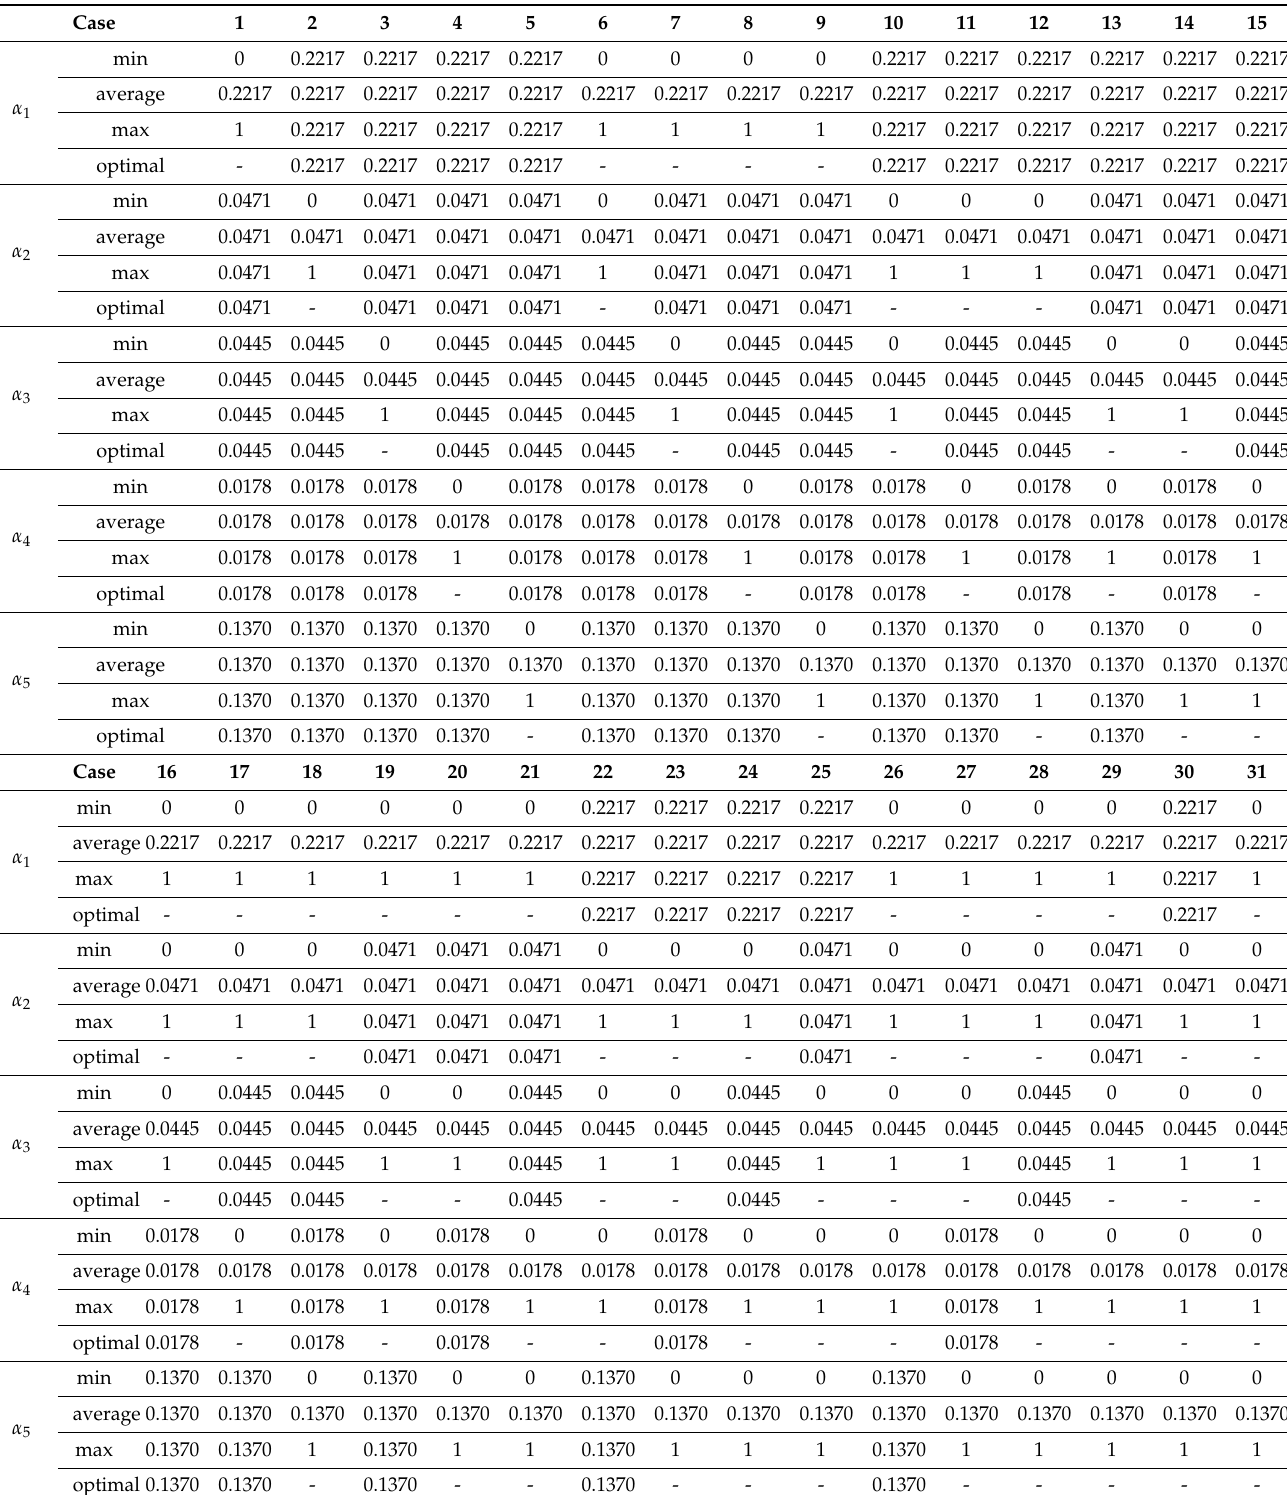
Table 6. Parameters of Figures